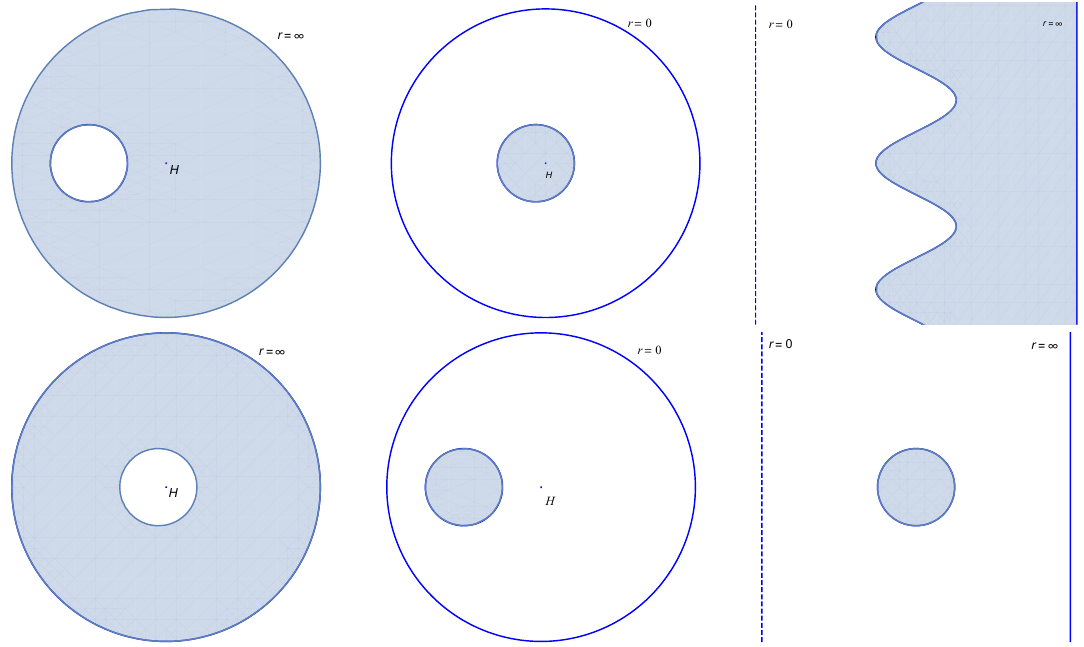
Figure 3 . Left: unshaded regions provide allowed Euclidean SAdS exteriors with r increasing outward for (cid:21) > (cid:0) ( (cid:20) (cid:0) 1) 2 (case ( I )) with (cid:22) i = 0. The angular direction is Euclidean time. Since (cid:11) e ( r max ) < 0, one must excise the (shaded) region r > r max . The sign of (cid:11) e ( r min ) is positive in the top panel and negative in the bottom panel. Center: allowed interiors for (cid:21) > 0 shown as (unshaded) regions of Euclidean dS with r increasing inward. Since (cid:11) i ( r min ) > 0, one must excise the (shaded) region r > r min . The sign of (cid:11) i ( r max ) is also positive at top but is negative at bottom. Right: allowed interiors for 0 > (cid:21) > (cid:0) ( (cid:20) (cid:0) 1) 2 shown as (unshaded) regions of Euclidean AdS, with r increasing to the right and Euclidean time running vertically. Here (cid:11) i ( r min ) > 0 requires one to excise the (shaded) region r > r min . The sign of (cid:11) i ( r max ) is also positive at top but is negative at bottom. Sewing any allowed interior to any allowed exterior shows the full solution to have no asymptotic